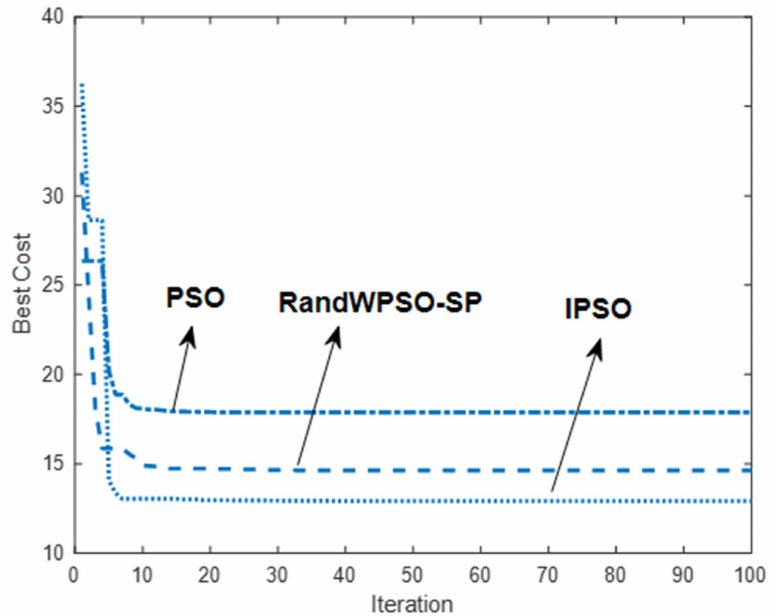
Figure 5. Iteration of three